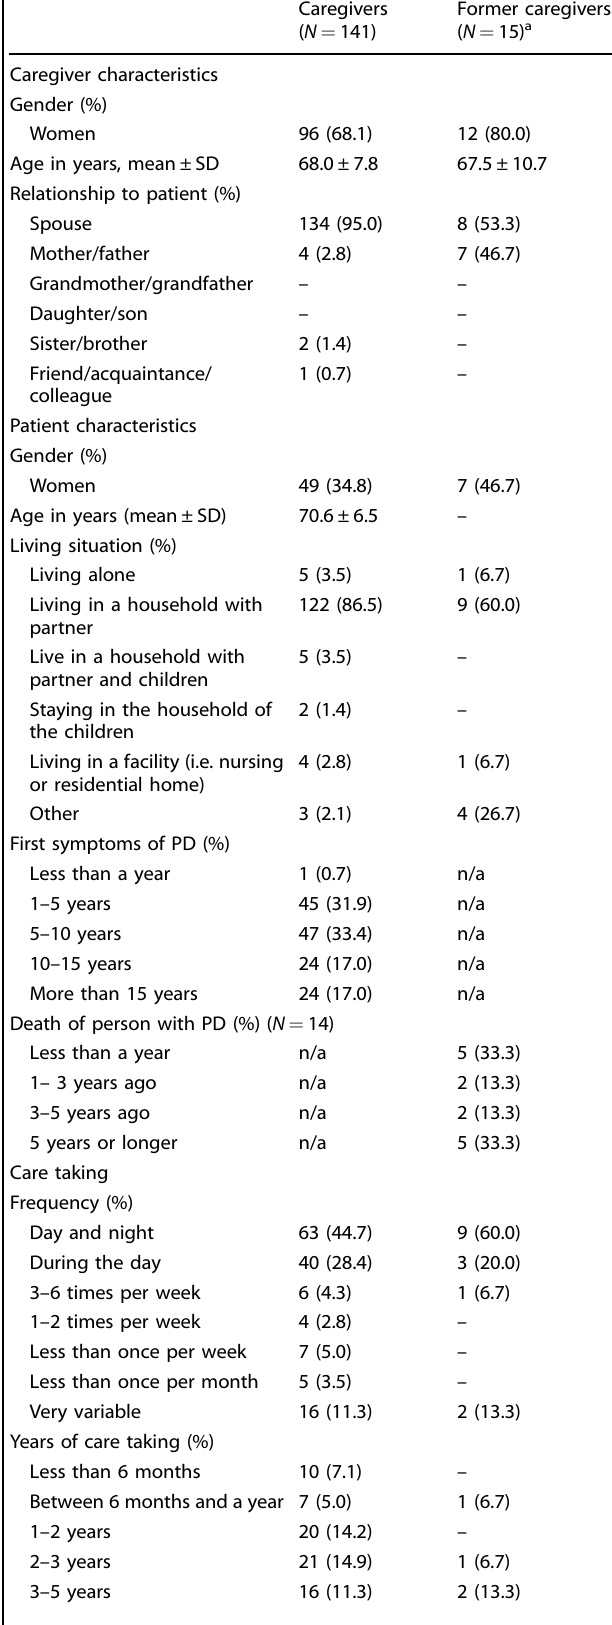
Table 1. Study sample